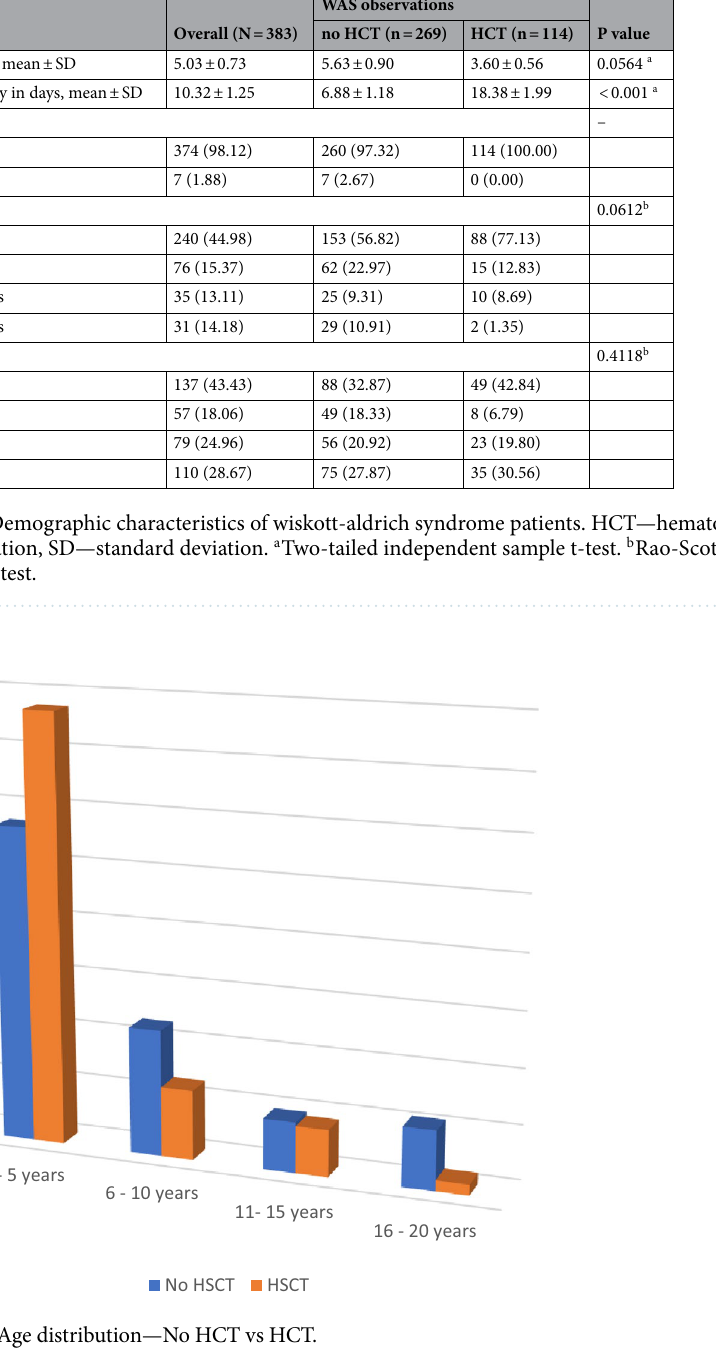
Figure 1. Age distribution—No HCT vs